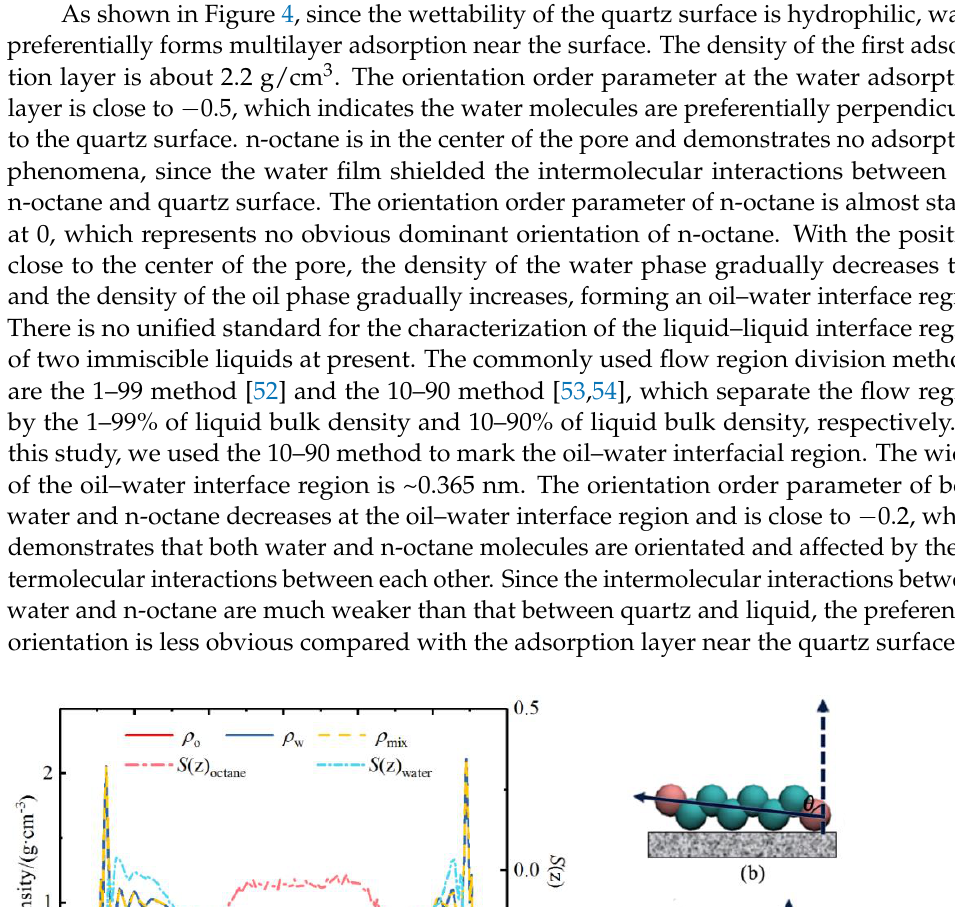
Figure 3. The equilibrium configuration of oil and water in 5 nm quartz nanopores (OMP = 50%).